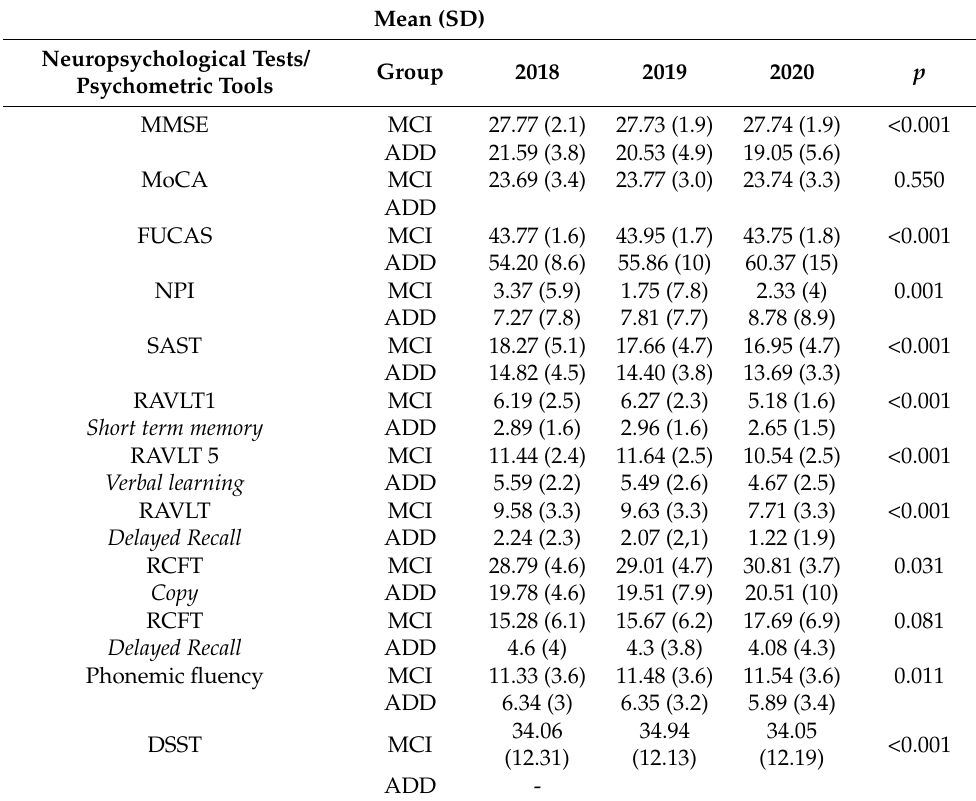
Table 2. Mean and standard deviation of the neuropsychological tests and mood-behavioral tests in MCI and ADD